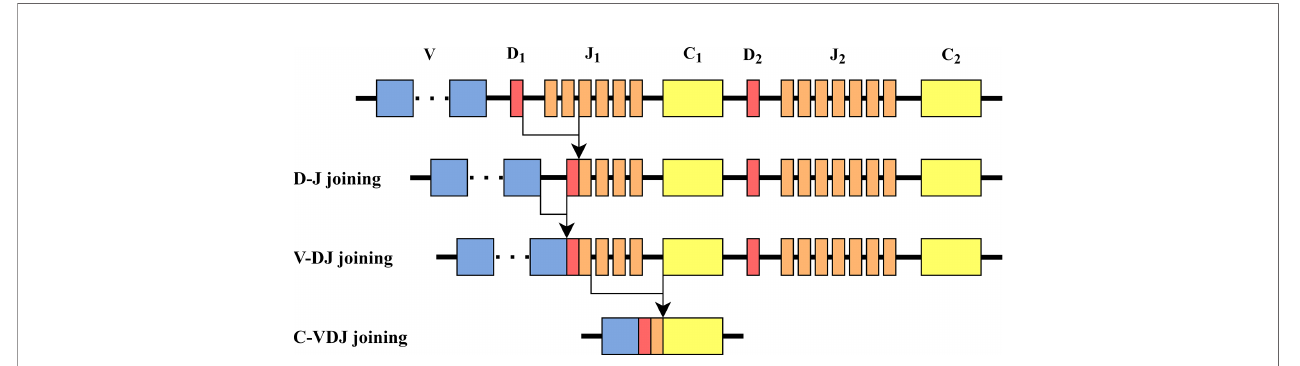
FIGURE 1 | TCR b chain rearrangement. First, D b and J b are bound, then V b is bound to D b J b , and then V b D b J b is bound to C b . The structure of the b chain in mice is similar to the one in